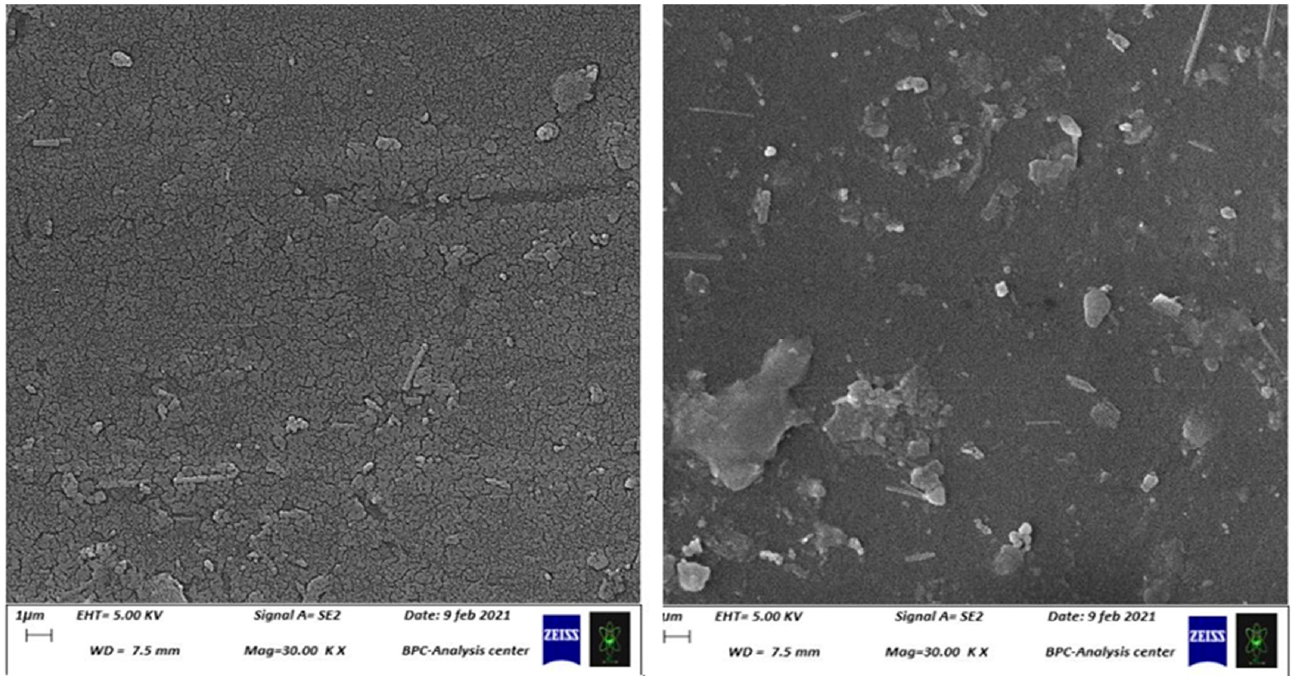
Figure 5. SEM surface images for ( Left ) pristine and ( Right ) 2.5 g PMG ‐ modified membranes.